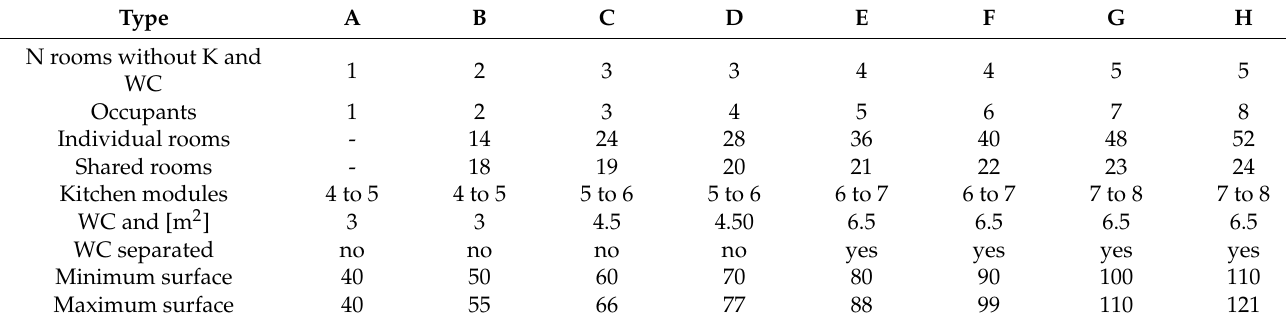
Table 8. Swiss dwelling definitions [55].